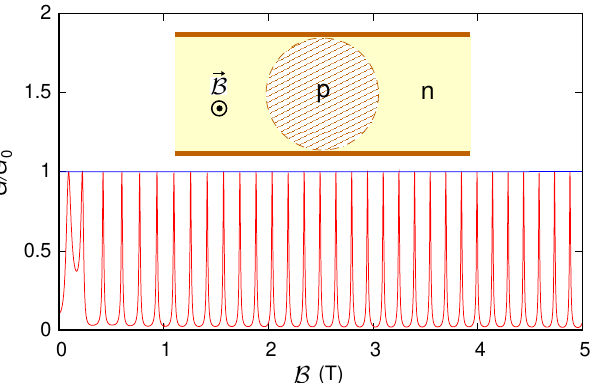
Figure 12. Conductance G , normalized with respect to the conductance quantum G 0 , which was obtained as a function of the orthogonal magnetic field B for the ribbon (with length 500 nm and width ∼ 200 nm) represented in the inset, where the presence of a Lorentzian-shaped potential introduces a circular p – n junction. The red curve indicates a semiconducting ribbon, while the blue line indicates a metallic